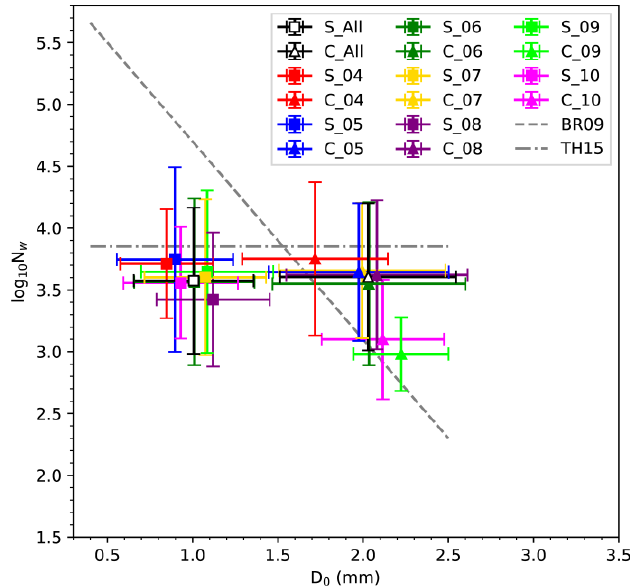
Figure 7. The MEAN values of log N w vs. D 0 together with the respective ± 1 × STD values plotted as error bars for convective (triangle) and stratiform (square) rain. The dataset for both rain types, including all data, are plotted in black, whereas the monthly results are indicated by different colors. The dashed and dot-dashed lines represent the C − S separation lines from BR09 and TH15, respectively.